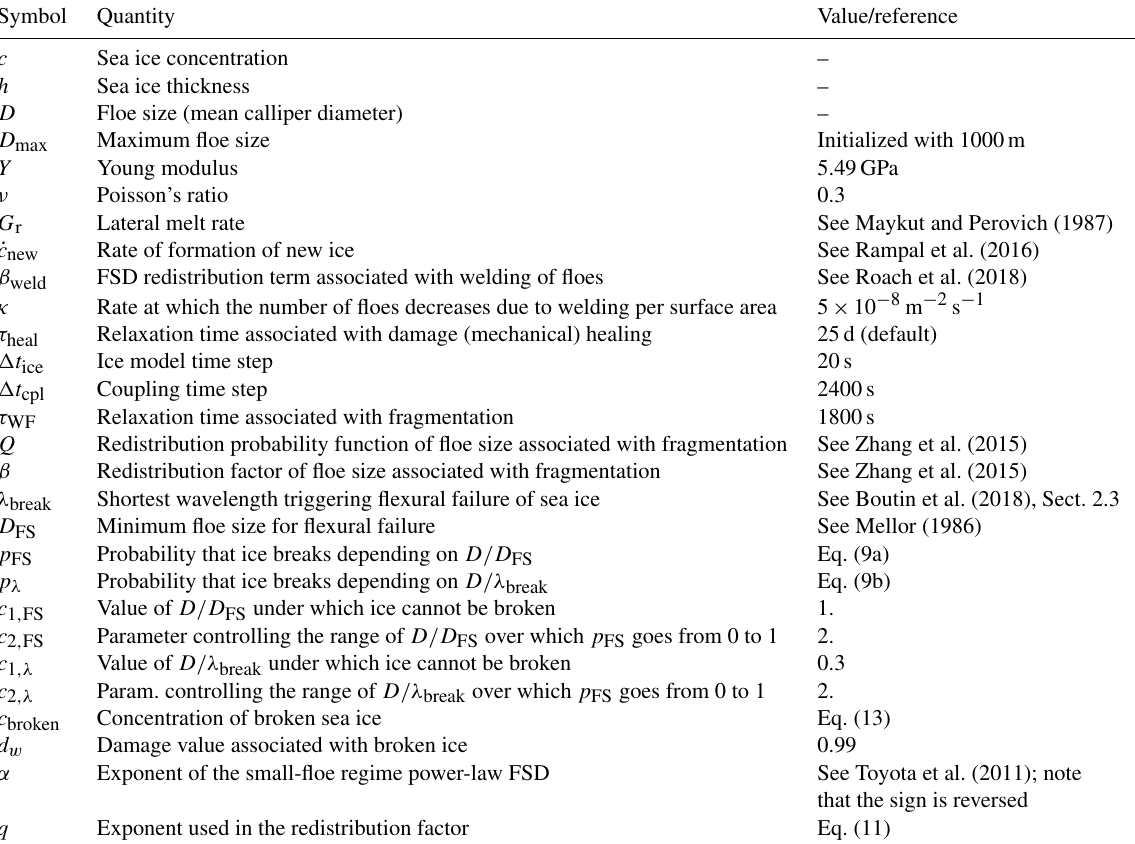
Table A1. List of symbols used in this study and their associated quantities. Parameter default values, or references used to compute each quantity, are indicated in the last